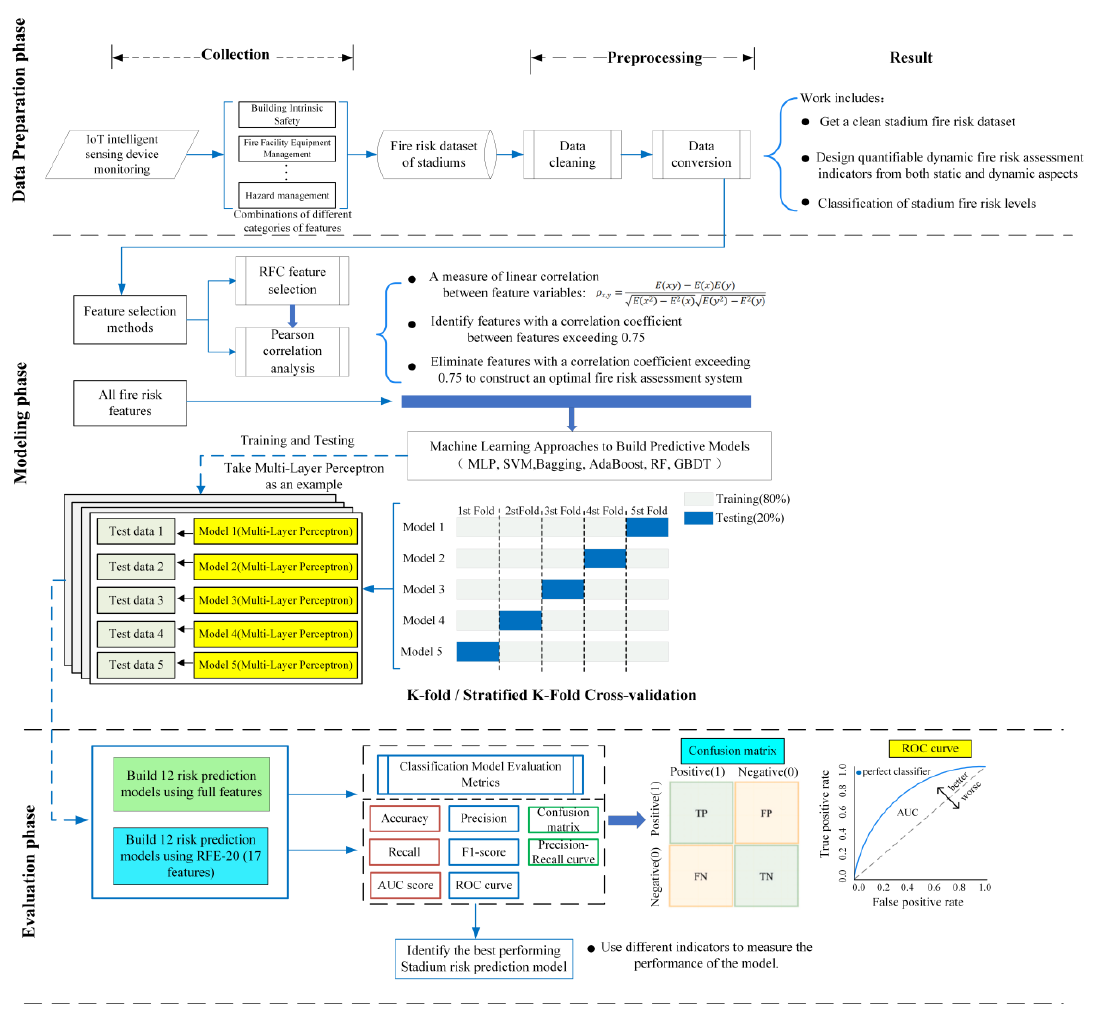
Figure 2. The main flow of the data mining method.